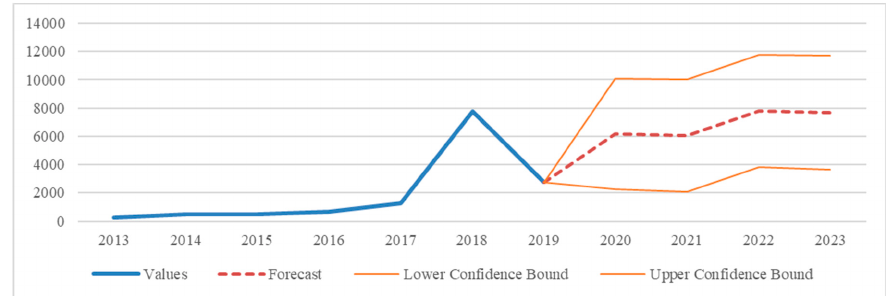
Figure 11. Venture capital investments in blockchain technology and future investment forecasts ($ million). Source: Calculated by the authors based on quarterly data from 2013 to 2019 using CB insights,